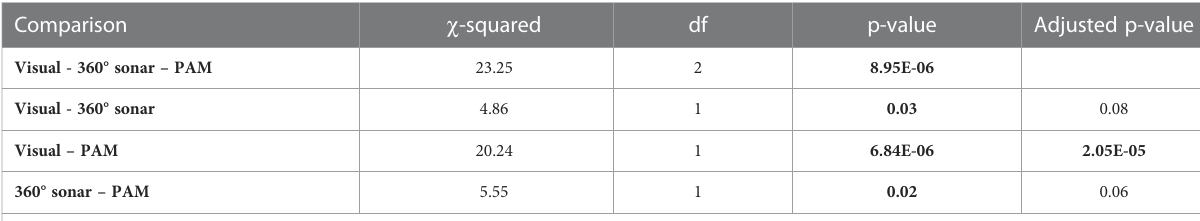
Adjusted p-values (with Bonferroni correction) highlight post-hoc comparisons. PAM = passive acoustic monitoring. Signi fi cant p-values are in bold.